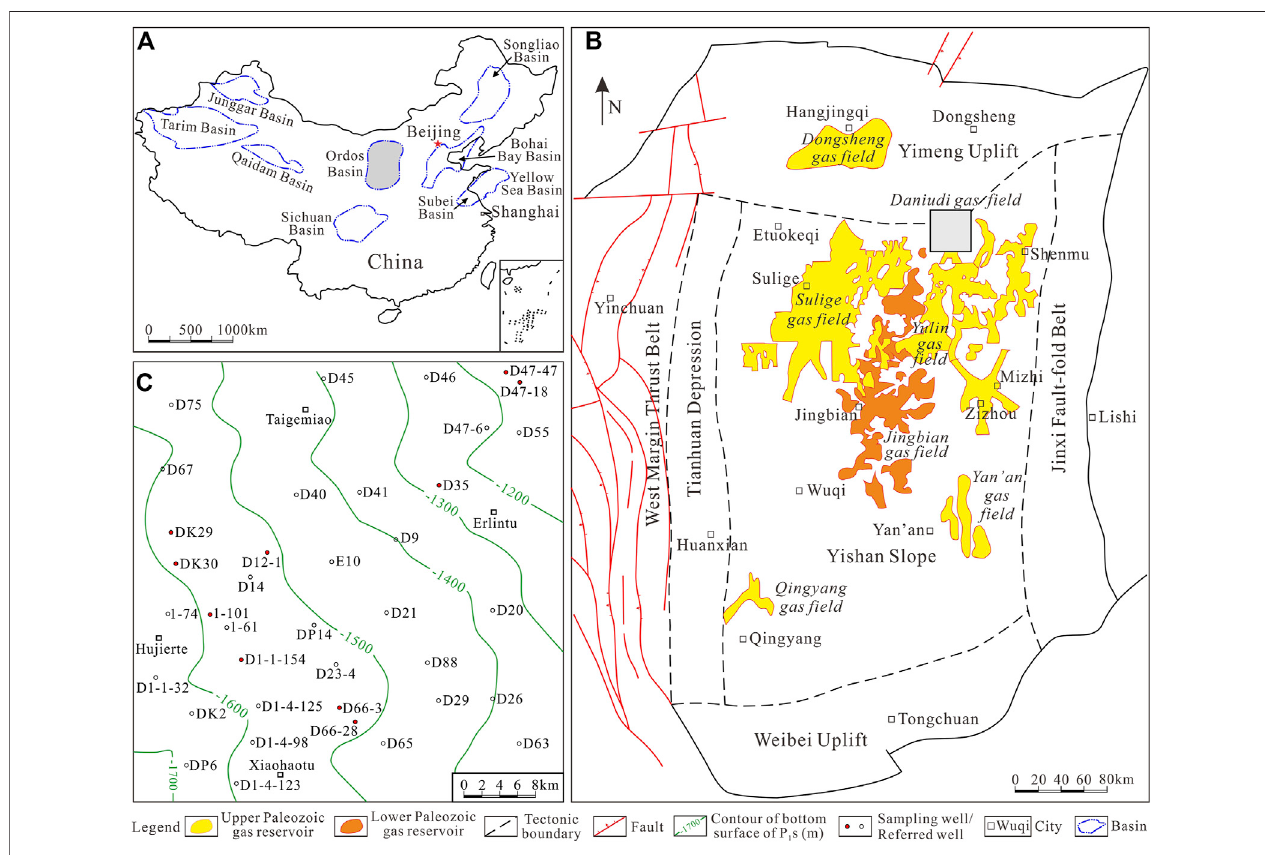
FIGURE 1 | The location of Ordos Basin in China (A) , location of the Daniudi gas fi eld in the basin (B) , and distribution of gas wells in the gas fi eld (C) .